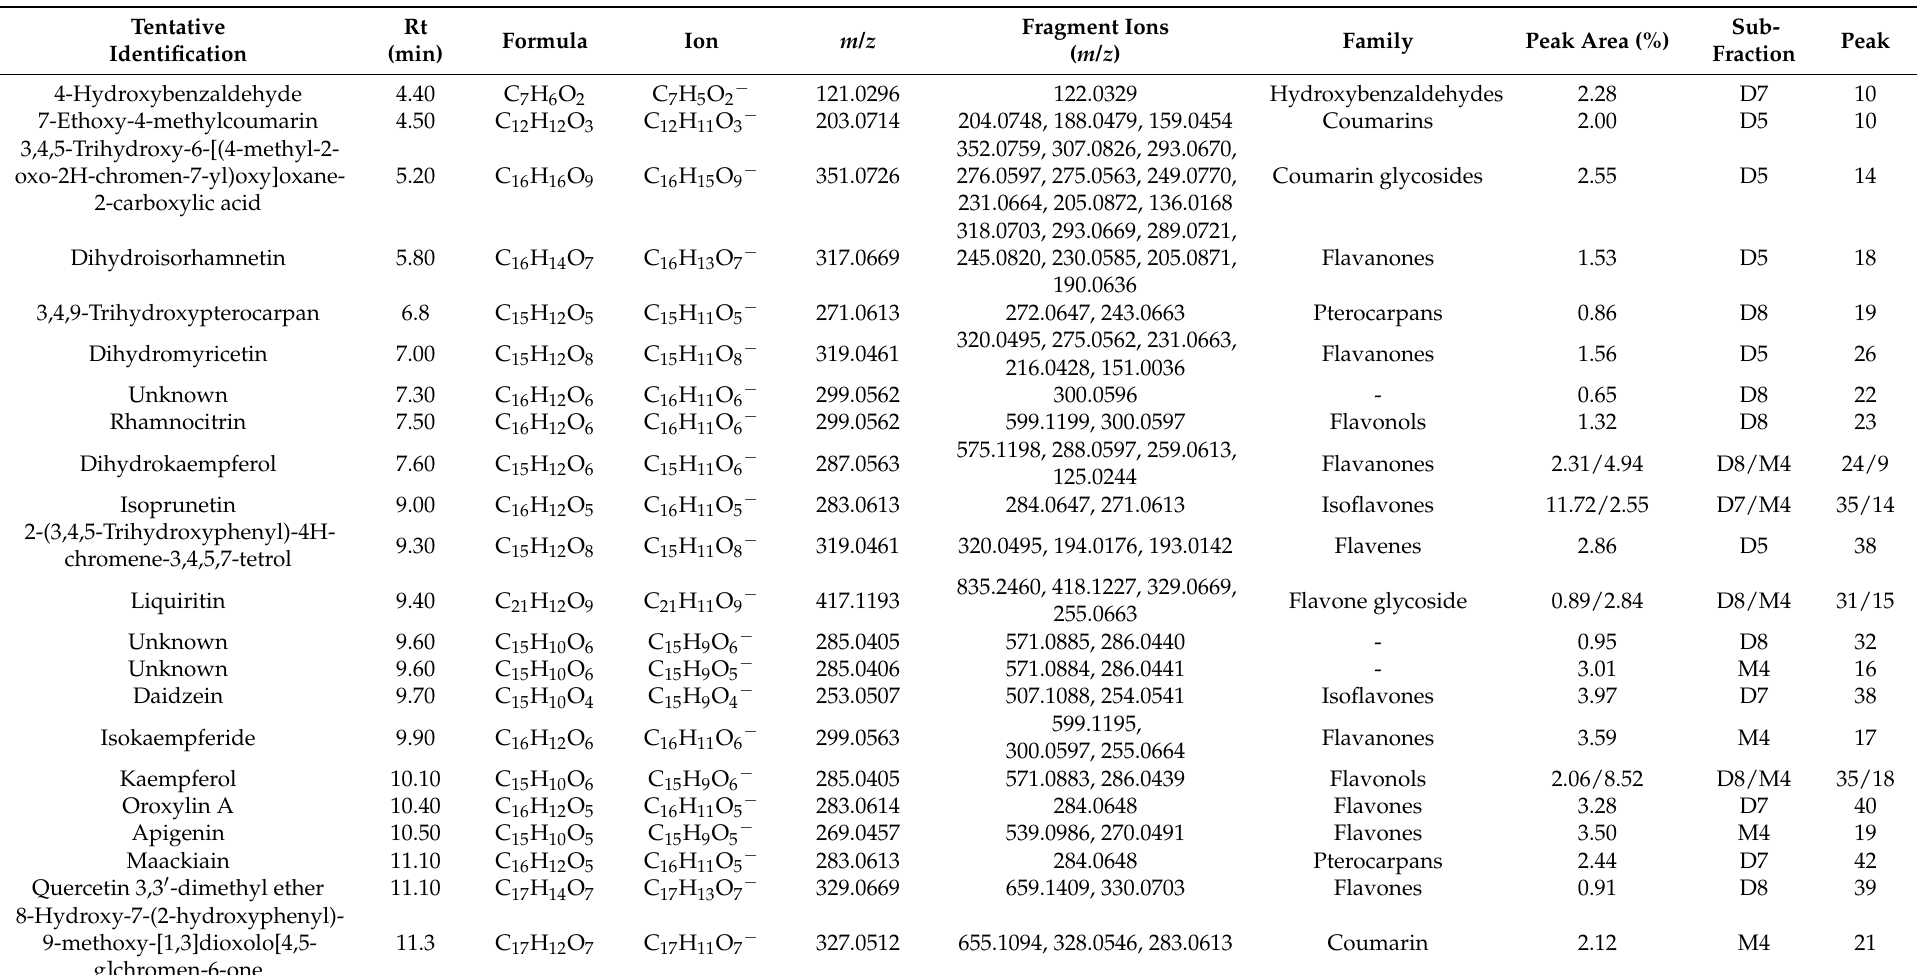
Table 6. Metabolites identified via untargeted analysis in the different sub-fractions using MS-Dial and MS-Finder (Rt = retention time and m / z = mass/charge ratio of the